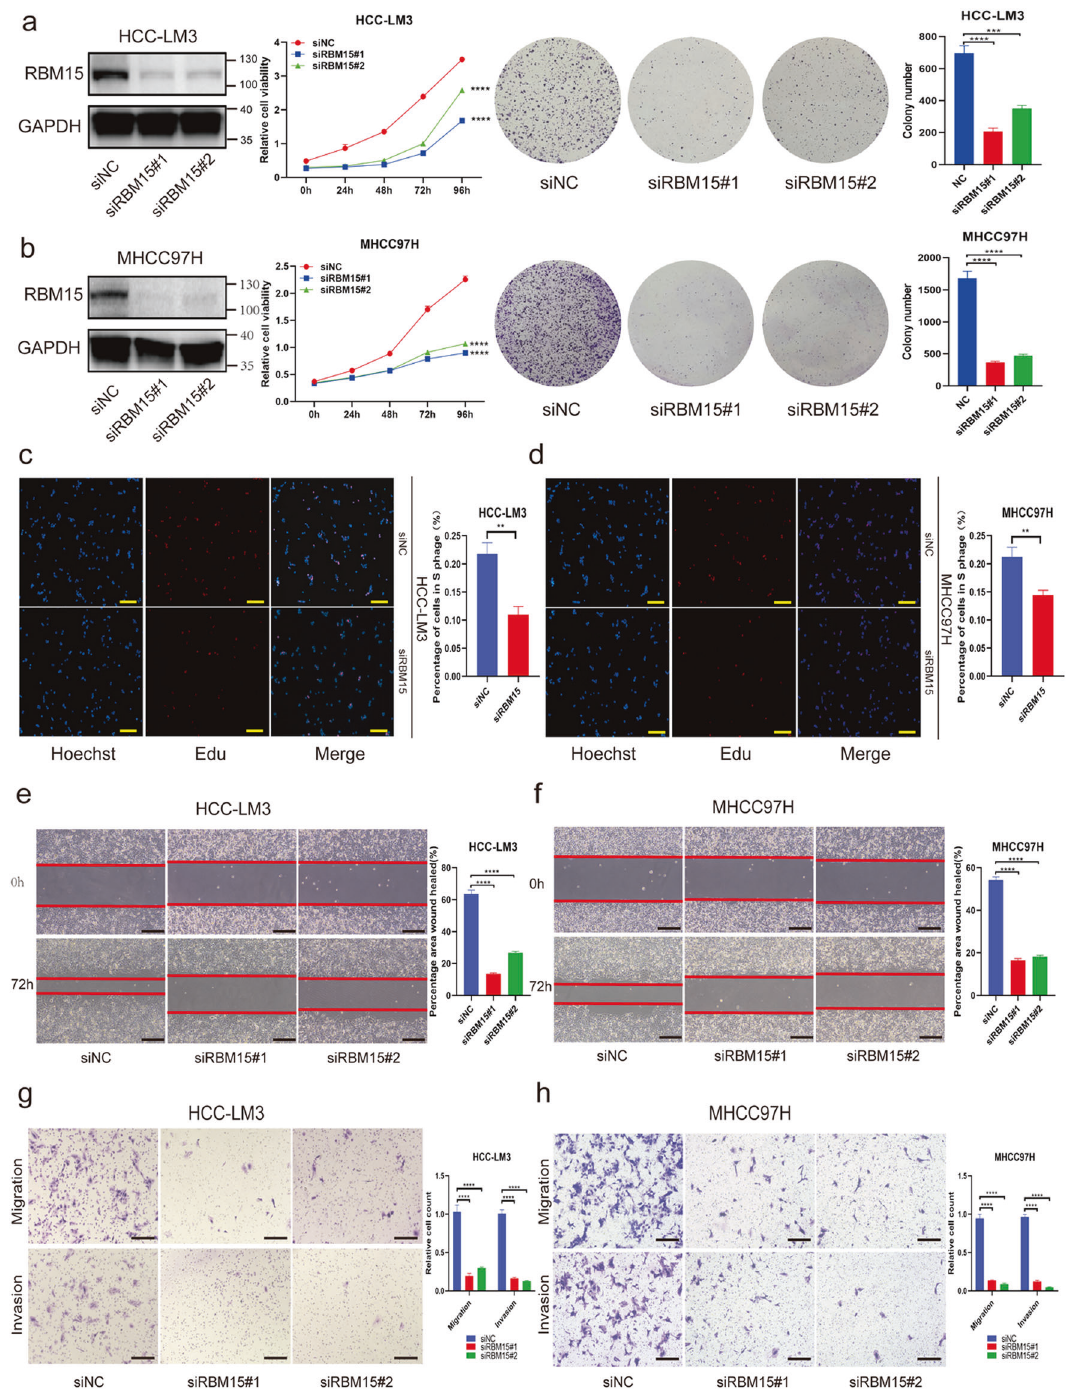
Fig. 3 RBM15 promotes tumor growth and migration/invasion capability of HCC cells in vitro. a , b Negative control or siRNA (si-RBM15#1 and #2) was transfected into HCC-LM3 ( a ) and MHCC97H ( b ), respectively. The ef fi ciency of knockdown was tested by western blotting and the proliferation capacities of HCC cells were detected by CCK-8 and colony-formation assays (*** p < 0.001, **** p < 0.0001; two-way ANOVA and t test); c , d EdU assays were applied to compare the proliferation abilities of HCC-LM3 ( c ) and MHCC97H cells ( d ) (scale bar, 200 μ m); bar charts showed the percentage of cells in S phage based on the results of EdU assays (** p < 0.01; t test); e , f wound-healing assays were performed to compared the migration capabilities of HCC-LM3 ( e ) and MHCC97H ( f ) cells (scale bars, 200 μ m); the percentage of healed area were quanti fi ed by bar charts (**** p < 0.0001; t test); g , h transwell assays were applied to detect the migration and invasion abilities of HCC-LM3 ( g ) and MHCC97H ( h ) cells after silencing RBM15 (scale bars, 200 μ m); bar charts showed the relative count of two groups of HCC cells, which passed through the chamber membranes when referred to negative control groups (**** p < 0.0001; t test); The data are presented as mean ± SD.